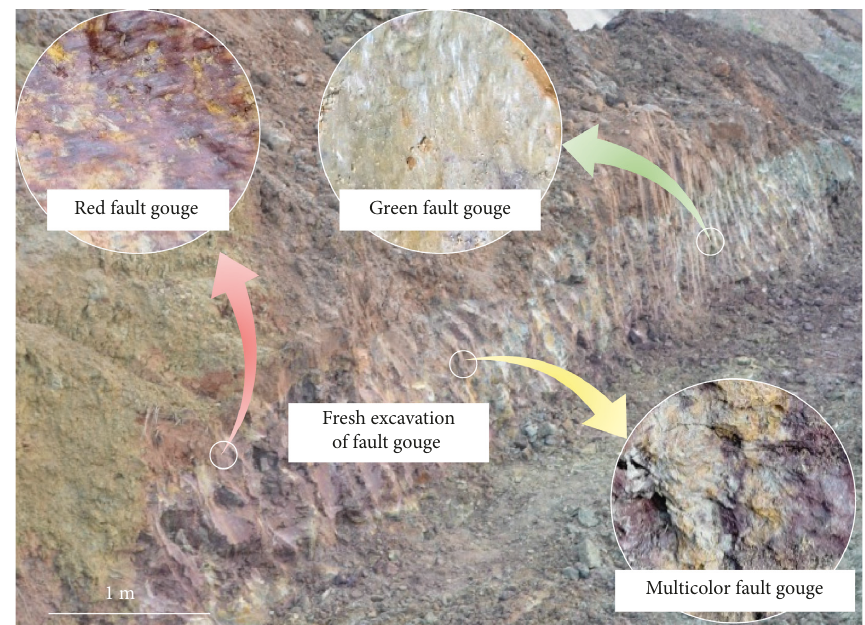
Figure 4: Fault gouges of different colors on site.